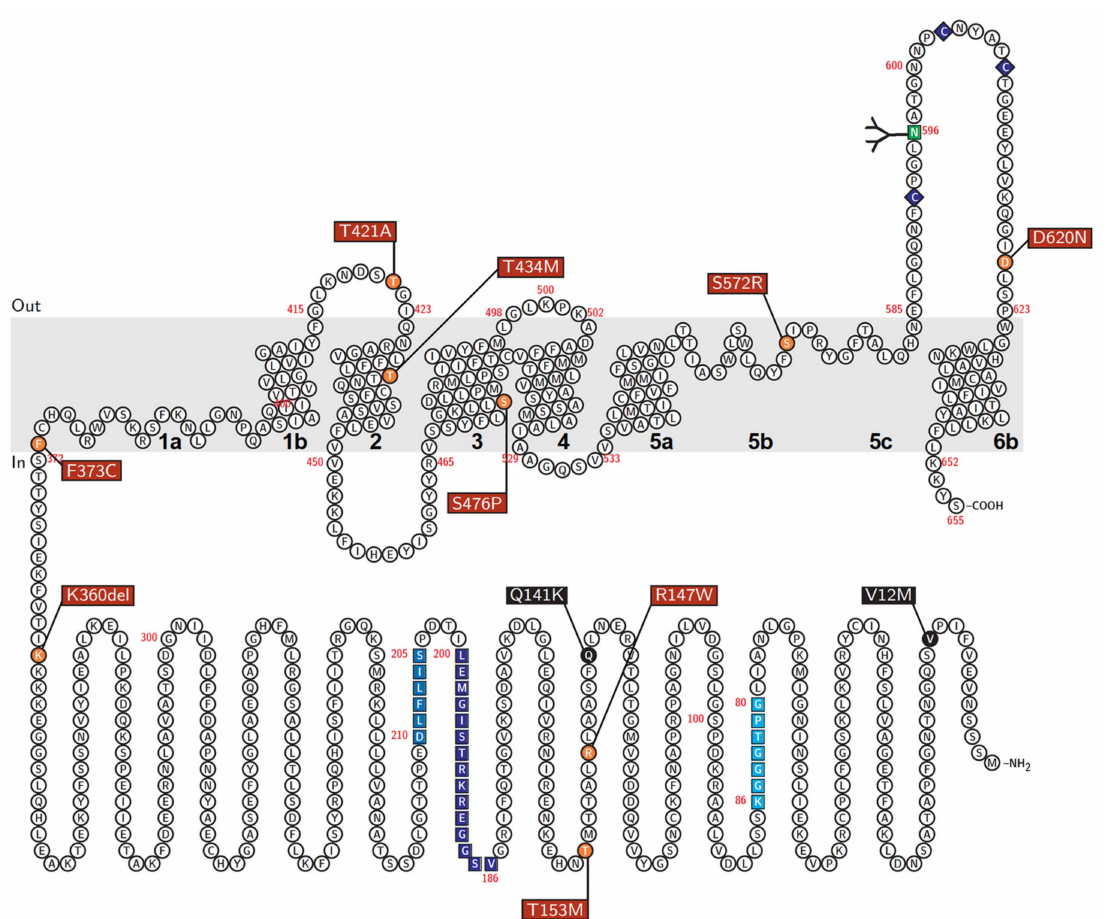
Figure 2. Schematic illustration of a putative topological model of human ABCG2 protein. Red box, rare variants analyzed in the present study; Black box , common variants. Helices in the transmembrane domain are numbered (1a to 6b) according to a previous study [34]. Asn596 is an N -linked glycosylation site. Unique motifs common to ABC proteins: Walker A (amino acids 80–86), Walker B (amino acids 205–210), and signature C (amino acids 186–200) in ABCG2 protein are indicated by